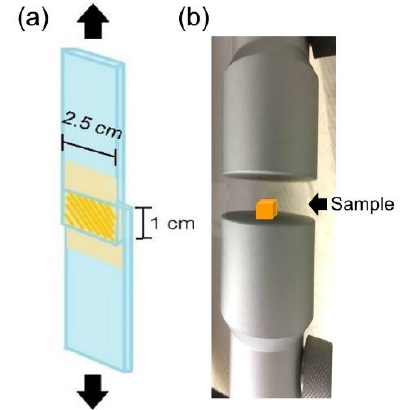
Figure 1. Schematically representation of the mechanical property test ( a ) shear strength test, and ( b ) compression test used in this